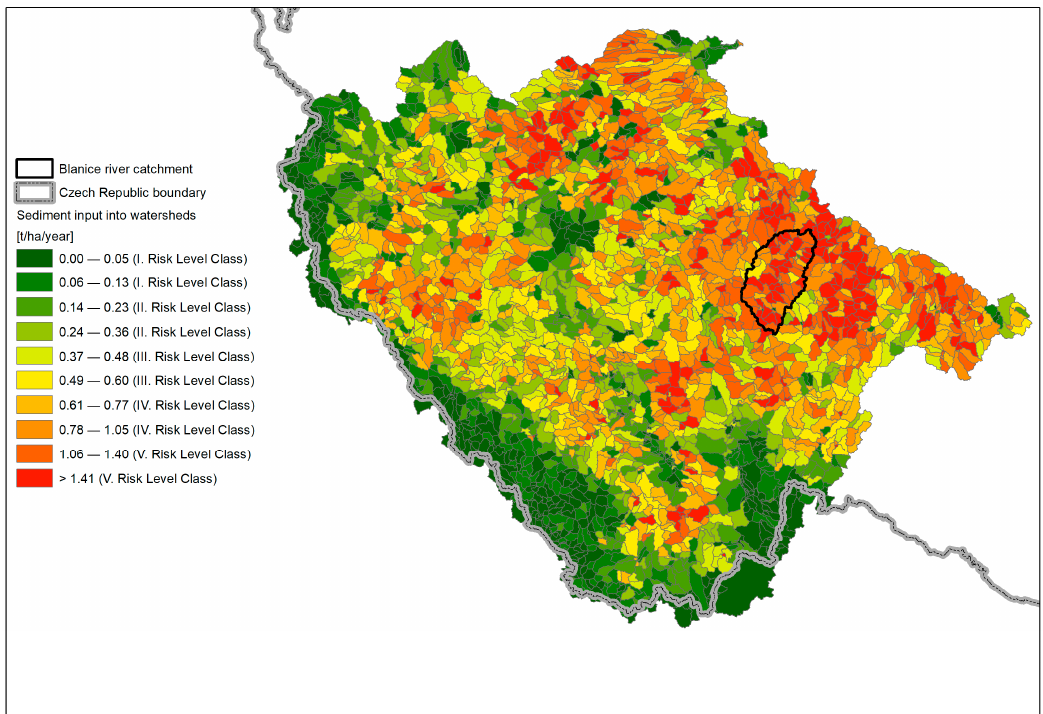
Figure 2. Sediment input into fourth-order catchments for the entire Vltava watershed area.